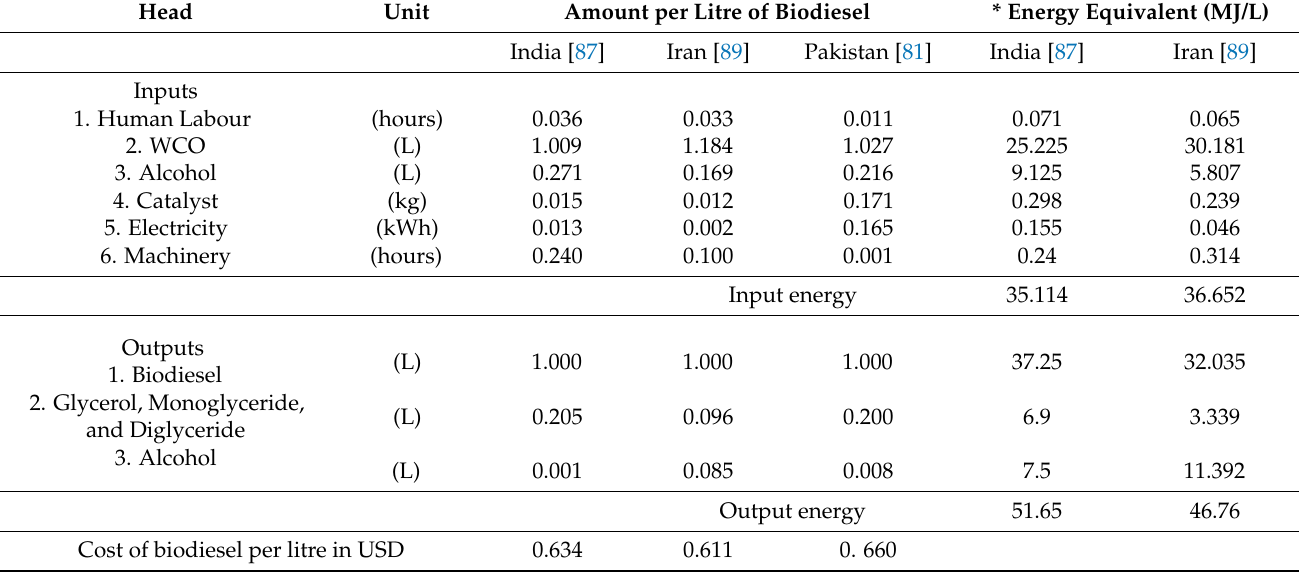
Table 3. Quantities inputs and outputs for producing one litre of biodiesel.